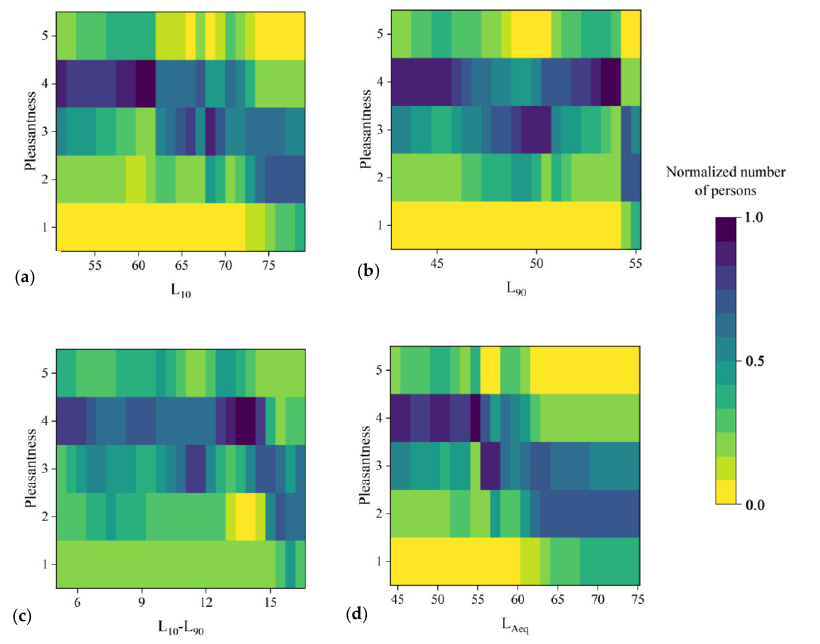
Figure 3. Distribution of soundscape pleasantness level and ( a ) L 10 , ( b )L 90 , ( c ) L 10 -L 90 and ( d ) L Aeq , in urban forests. Table 1. Relationship between acoustic parameters and perceived pleasantness in different forest structures, where Pearson correlation coefficients are shown in each